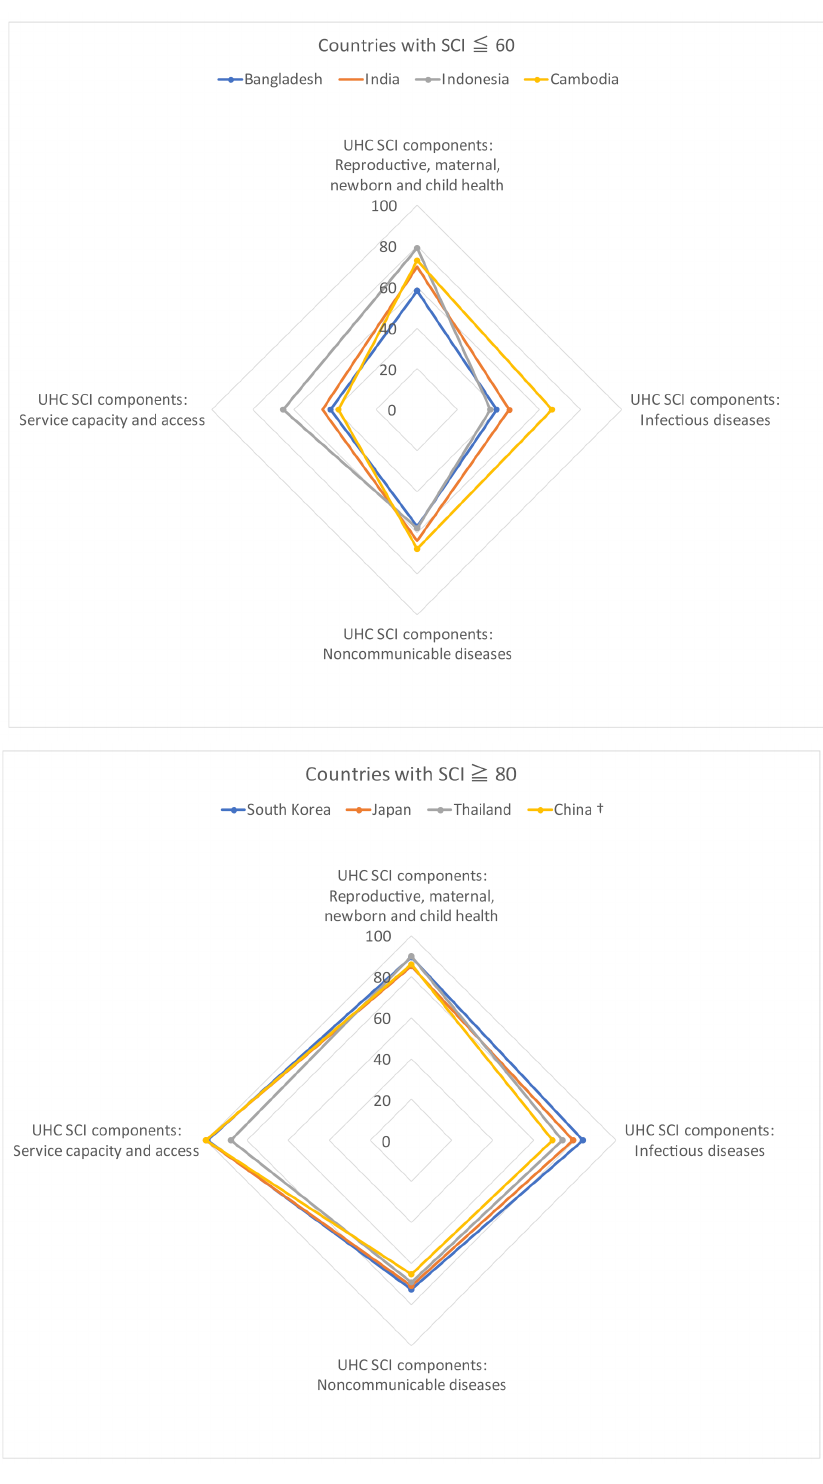
Figure 2. Distribution composition of SCI components by SCI level (60 or below and 80 or above). (†) China has an SCI of 79, but it is shown because it is as close as possible to the relevant group. Note: SCI, service coverage